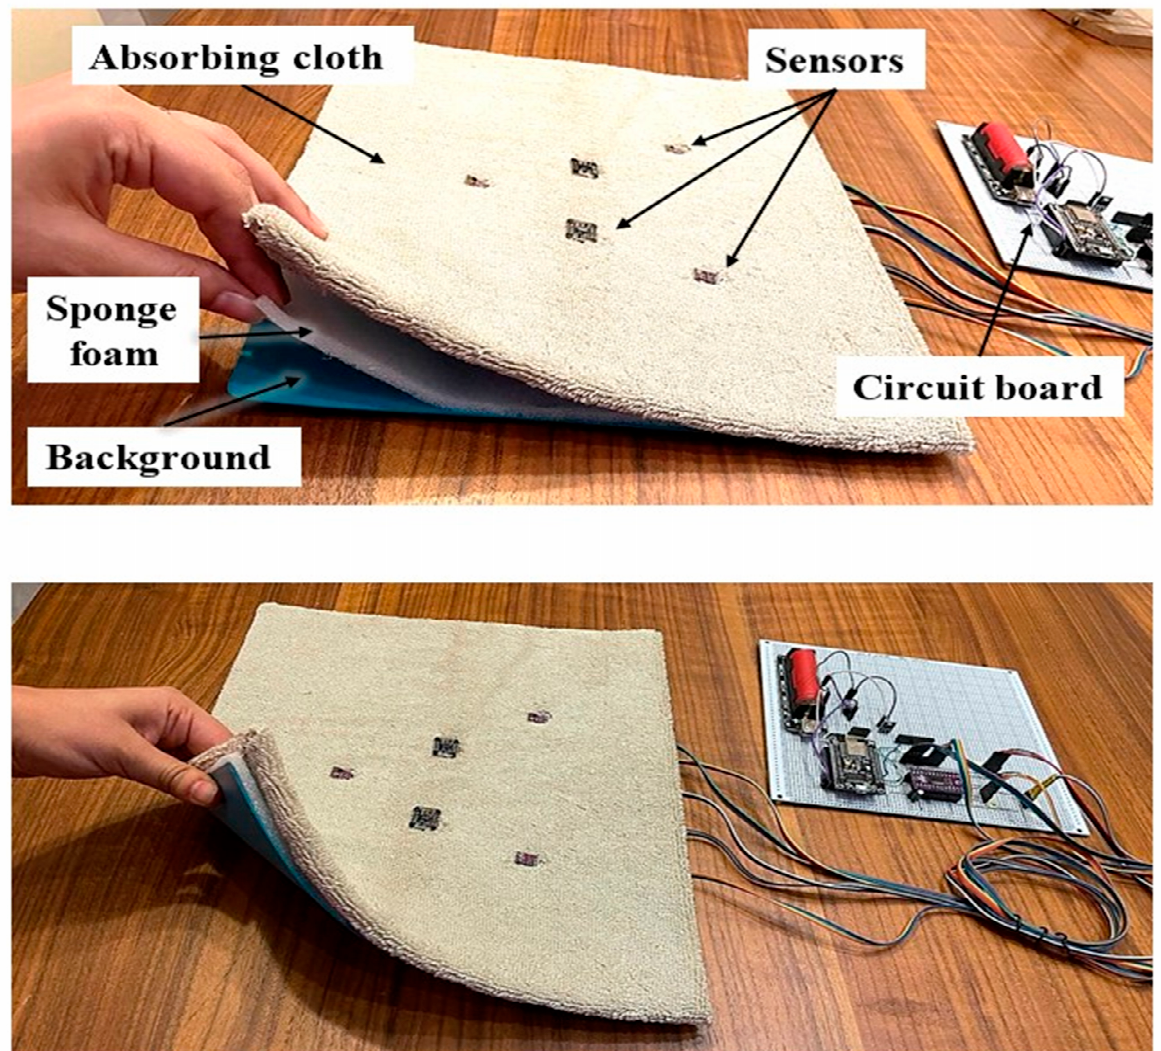
Figure 3. Fabrication of the ulcer-sensing pad showing its flexibility and multiple layers.